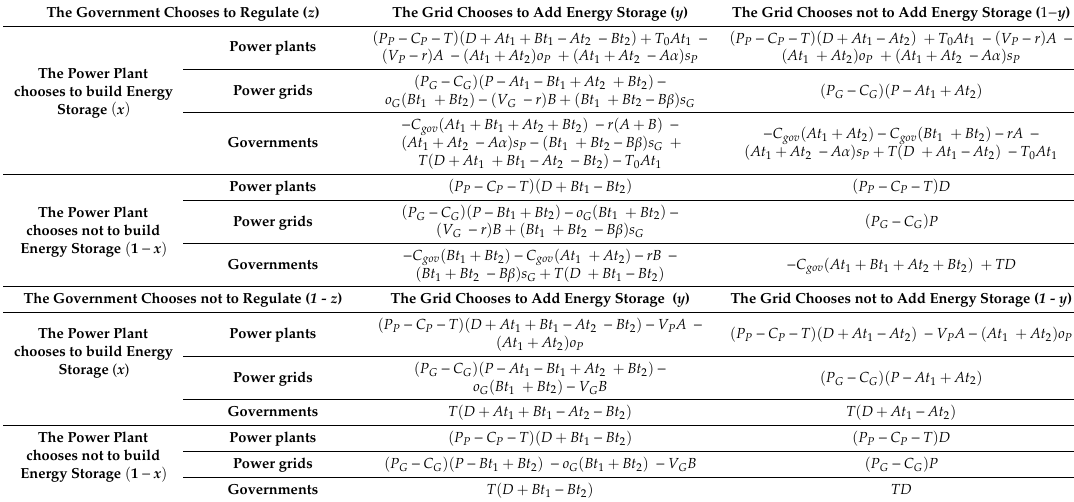
Table 4. Evolutionary game payo ff